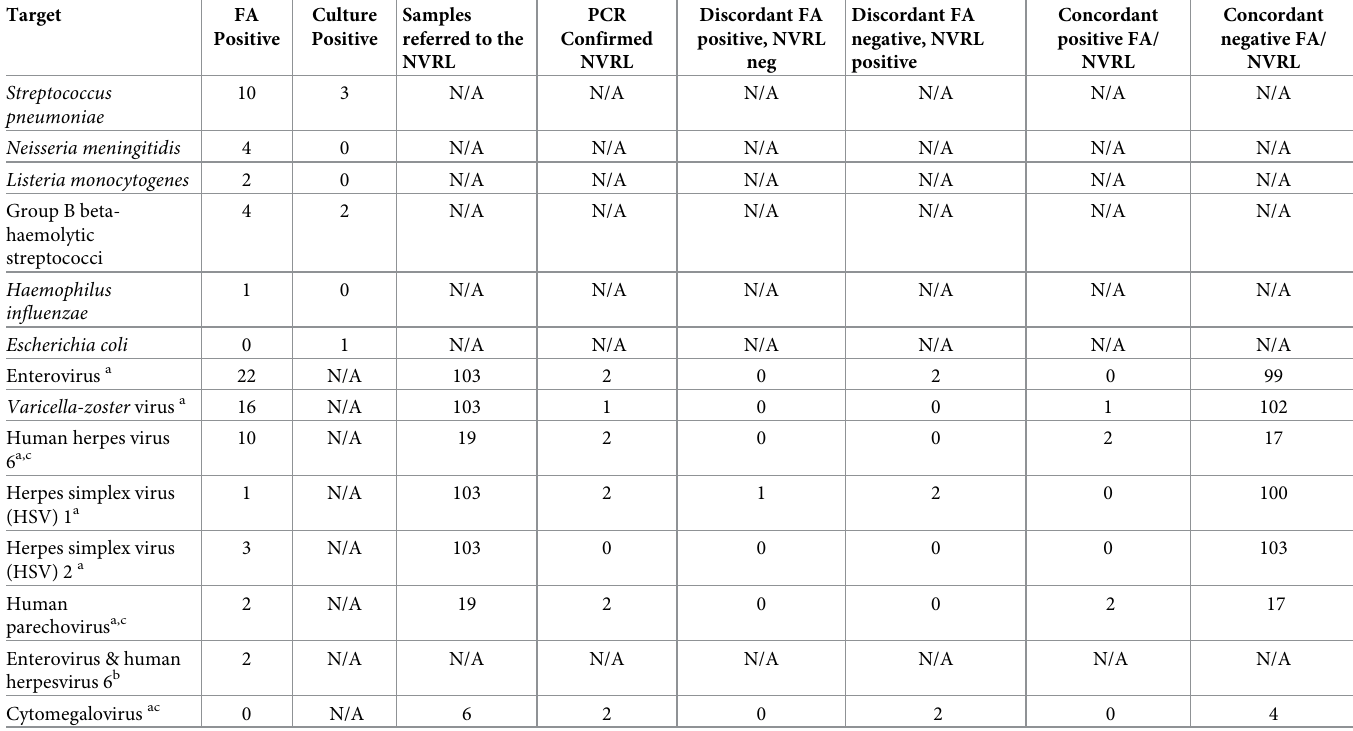
Table 1. Positive results for FilmArray ME panel in